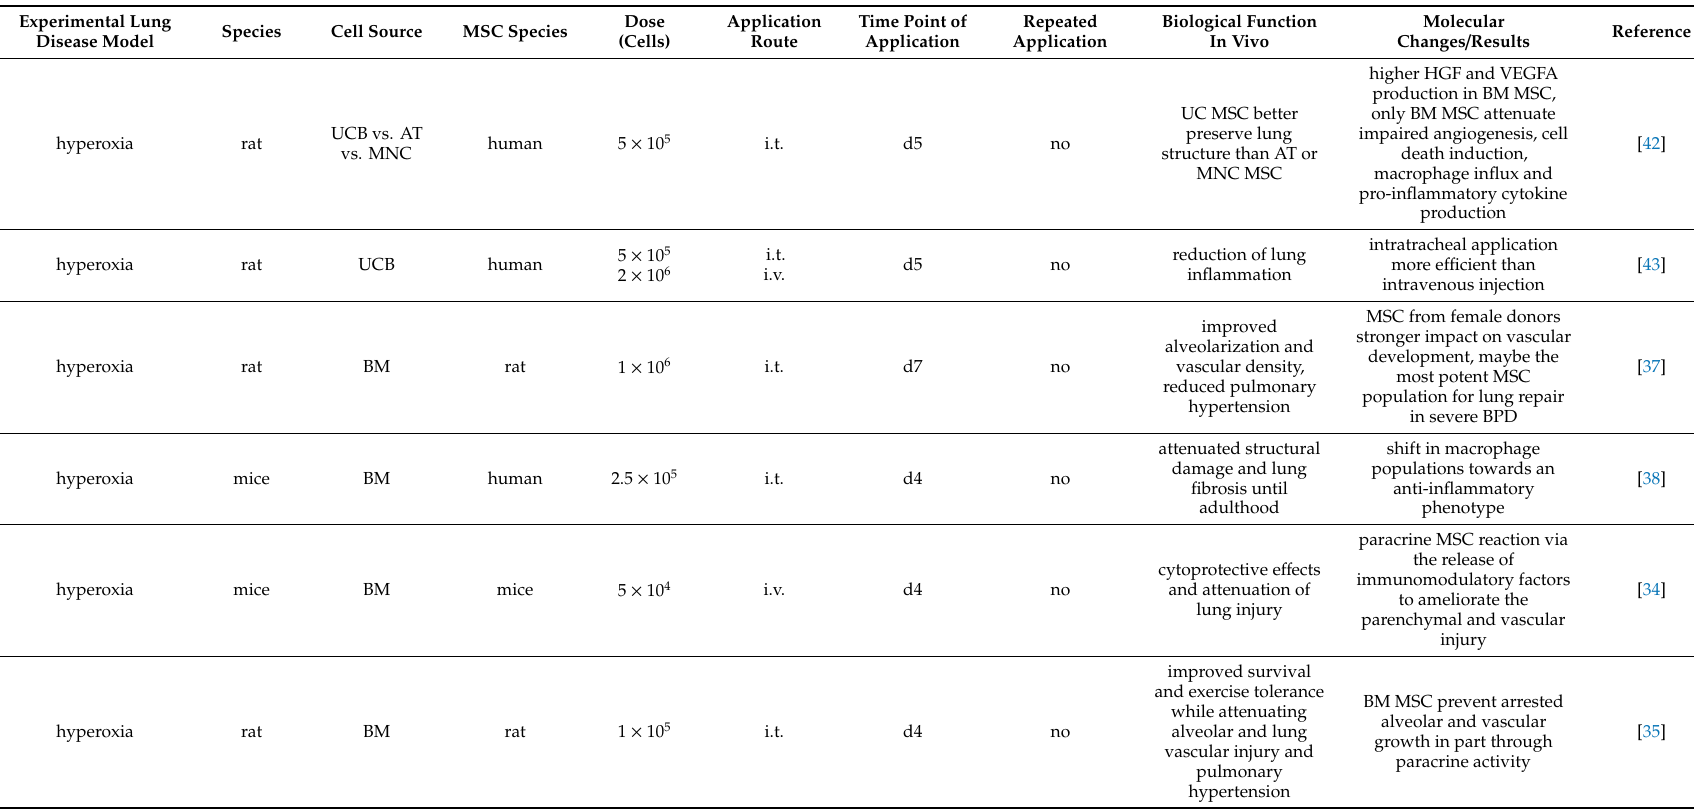
Table 1. Summary of important preclinical studies in rodents examining the e ffi cacy of MSC to prevent / treat bronchopulmonary